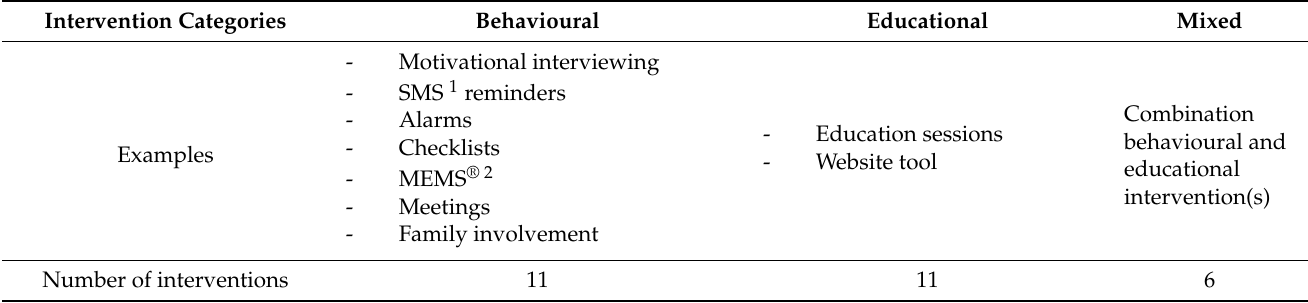
Table 2. Overview of the types of interventions included in selected